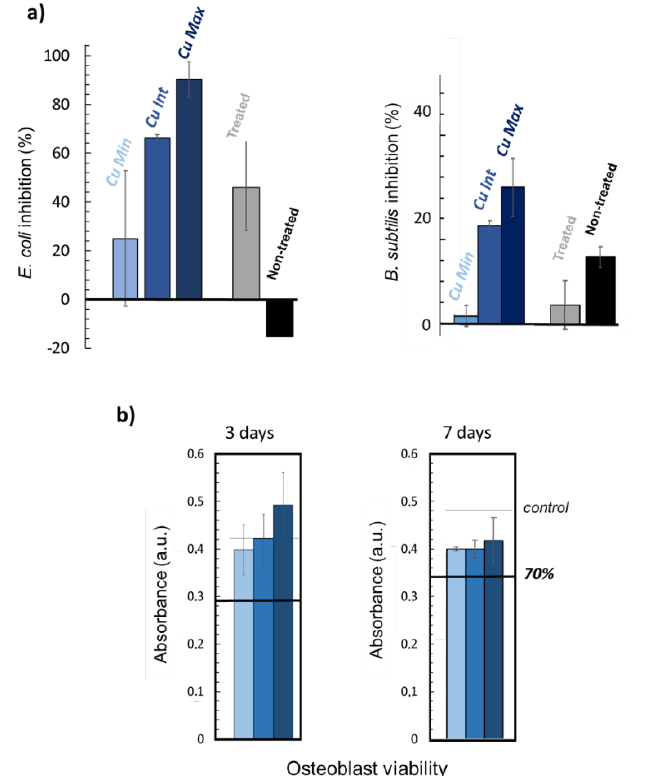
Figure 9. In vitro evaluations of Cu-doped samples: ( a ) Antibacterial effect on E. coli and B. subtilis bacteria, ( b ) Osteoblast viability at days 3 and 7. The dark line represents the values corresponding to 70% cell viability.